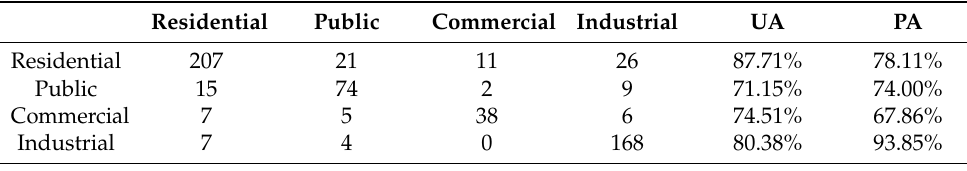
Table 4. Grid confusion matrix for Level I (Moore Neighborhood addition).